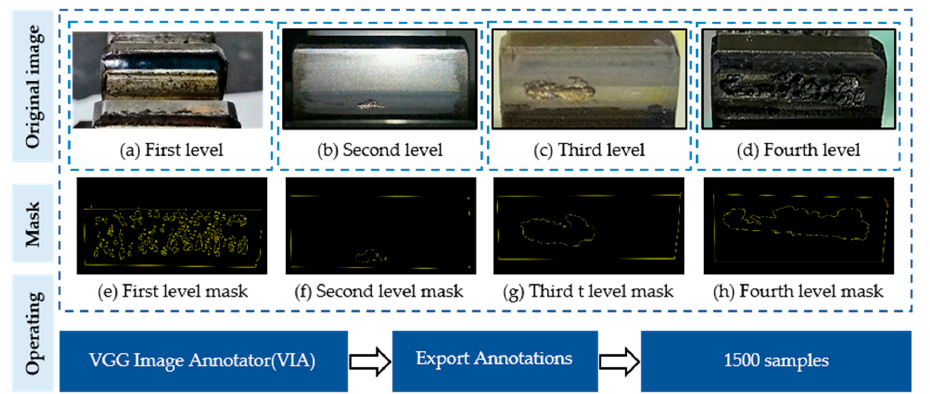
Figure 6. Images labeling. (a), (b), (c), (d) were the original images of different levels, (e), (f), (g), (h) were the label image of different levels.